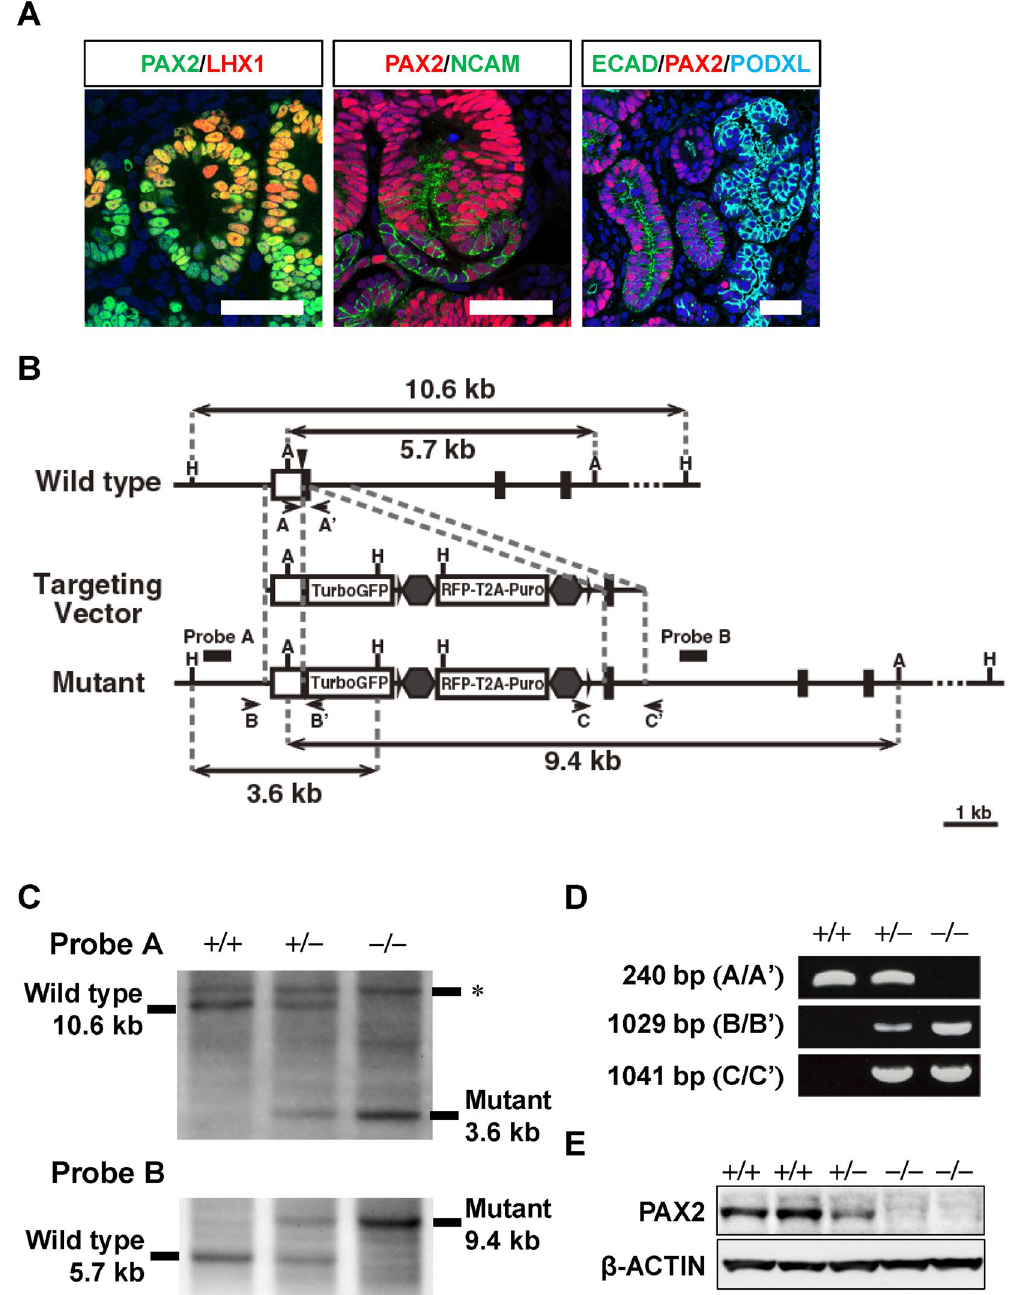
Figure 1. Generation of PAX2 -deficient human iPS cells. ( A ) PAX2 staining during nephron formation from the parental iPS clone. PAX2 is expressed in the renal vesicles (left panel: green), NCAM + S-shaped bodies (middle panel: green), and E-cadherin (ECAD) + distal renal tubules (right panel: green). LHX1 (left panel: red) is expressed in a portion of renal vesicles, and podocalyxin (PODXL; right panel: blue) is expressed in glomeruli. Scale bars: 50 µ m. ( B ) Strategy for targeting the human PAX2 gene. The TurboGFP and RFP cassettes are inserted into the PAX2 locus. The RFP and Puro cassettes are sandwiched by loxP (arrowheads) and insulator sequences (hexagons). A, ApaL I; H, Hind III. ( C ) Southern blot analysis of wild-type, heterozygous ( + / − ), and homozygous ( − / − ) clones. Genomic DNAs were digested with Hind III (upper panel) or ApaL I (lower panel) and hybridised with the indicated probes. The positions of the probes are indicated in ( B ). * Non- specific bands. ( D ) PCR screening of homologous recombinants. The positions of the primers are indicated in ( B ). ( E ) Western blot analysis of PAX2 in nephron progenitors derived from iPS